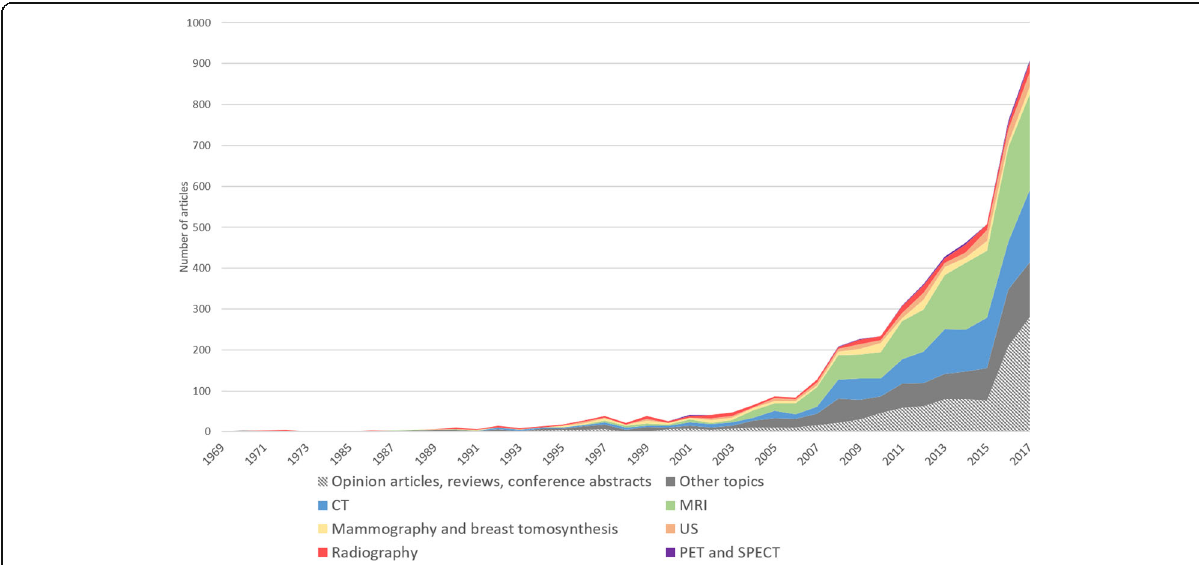
Fig. 4 Number of publications indexed on EMBASE obtained using the search query ( ‘ artificial intelligence ’ /exp. OR ‘ artificial intelligence ’ OR ‘ machine learning ’ /exp. OR ‘ machine learning ’ OR ‘ deep learning ’ /exp. OR ‘ deep learning ’ ) AND ( ‘ radiology ’ /exp. OR ‘ radiology ’ OR ‘ diagnostic imaging ’ /exp. OR ‘ diagnostic imaging ’ ) AND ([english]/lim). EMBASE was accessed on April 24, 2018. For each year the number of publications was stratified for imaging modality. US ultrasound, MRI magnetic resonance imaging, CT computed tomography, PET positron emission tomography, SPECT single-photon emission tomography. Diagnostic modalities different from those listed above are grouped under the “ other topic ” label (e.g.